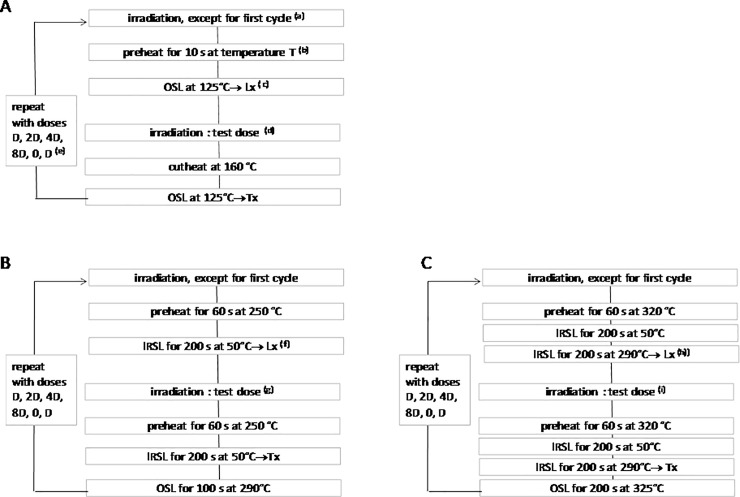
Protocols applied to the quartz or feldspar grains.A) SAR, B) IR50, C) PIR-IR290. (a) For the dose recovery tests, a dose close to the estimated De was given. (b) For the preheat plateau tests, the temperature T was set to 220, 240, 260 or 280 °C. (c) For the single quartz grains measurement, the OSL excitation was performed for 0.85 s; the first 0.05 s and last 0.1 s were taken for signal and background respectively; for the multiple quartz grains measurements, the OSL excitation was performed for 100 s; the first 2 s and last 20 s were used for signal and background respectively. (d) The test dose was either 7 Gy (BRS1 and 2) or 140 Gy (BRS3 and BRS4). (e) D was chosen close to the estimated De. (f) The first 7.6 s and last 20.4 s out of 200 s were used as signal and background respectively. (g) The test dose was either 32 Gy (BRS2) or 65 Gy (BRS3 and BRS4). (h) The first 8.0 s and last 18.4 s out of 200 s were used as signal and background respectively. (i) The test dose was either 16 Gy (BRS1 and 2) or 78 Gy (BRS3 and BRS4).